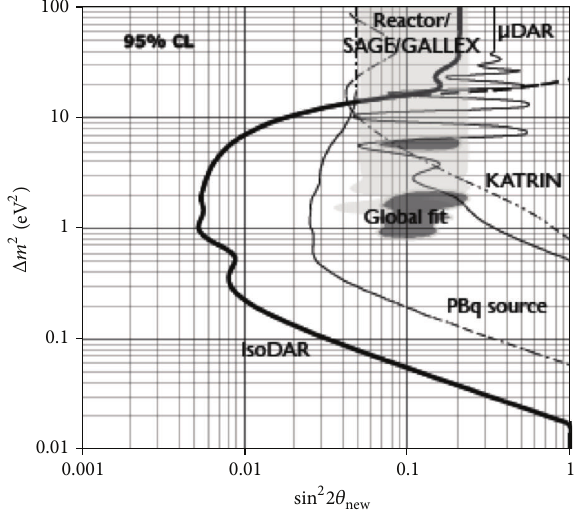
Figure 22: The sensitivity of the IsoDAR experiment to ] 𝑒 disap- pearance in a five-year physics run (from